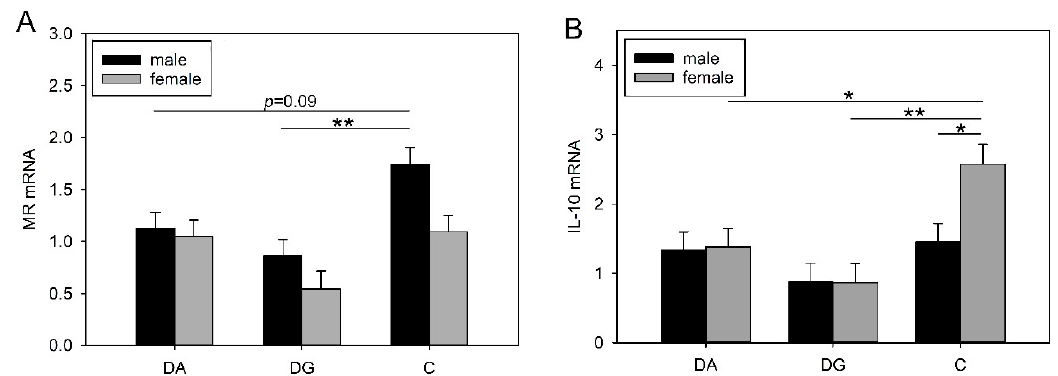
Figure 5. MR ( A ) and IL-10 ( B ) mRNA expression in the amygdala of DA (deprivation alone), DG (deprivation with a group of littermates) and C (control, no deprivation) piglets, 24 h after LPS application. Data are expressed as arbitrary units after normalisation to ACTB and TBP mRNA expression as endogenous reference genes and represent the LS means ± SE. Significant differences are indicated by asterisks (* p ≤ 0.05; ** p < 0.01; n = 7 pigs per treatment group and sex).